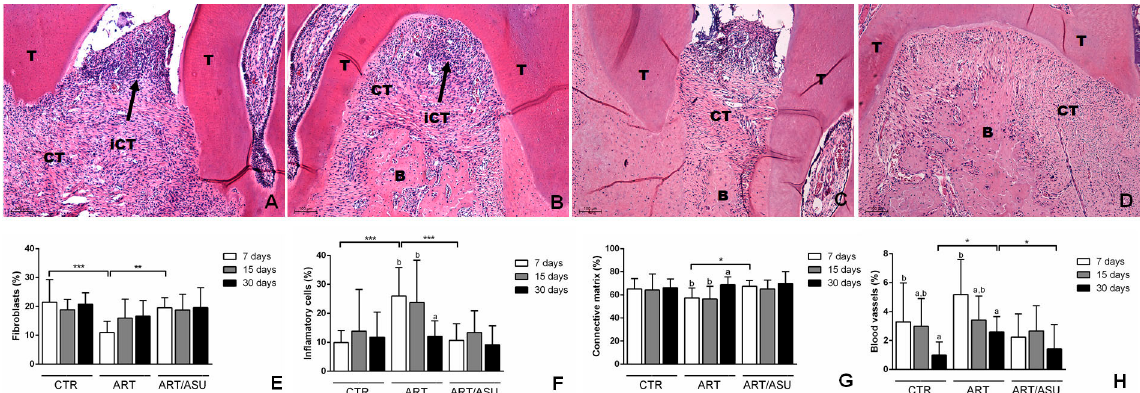
Figure 4- Representative histological images and graphs from the stereometric analysis. A) Interproximal region image representative of the ART group at the period of 7 days, and B) Furcation region image representative of the ART group at the period of 7 days. In both images, the presence of inflammatory infiltrate (black arrows) can be noticed as associated with destruction of bone and reduction of extracellular matrix component and fibroblasts. C) Representative image of the interproximal region of the CTR and ART/ASU groups at the 7-day period; and D) the representative image of the furcation region of the CTR and ART/ASU groups at the 7-day period. The presence of the inflammatory infiltrate may also be noted in these groups, but to a lesser extent than in the ART group. E) Fibroblasts; F) Inflammatory cells; G) Extracellular connective tissue matrix; and H) Blood vessels. In general, the CTR and ART/ASU groups presented more fibroblasts and less inflammatory cells than the ART group at the 7-day period. *p<0.05; **p<0.01; ***p<0.001 – Significant differences between the groups–One-way ANOVA complemented by Tukey‘s test; Different letters represent different levels of significant differences within each group – One-way ANOVA complemented by Tukey‘s test (Original augmentation 100x-HE). B, bone; CT, connective tissue; iCT, inflammatory infiltrate; T, tooth